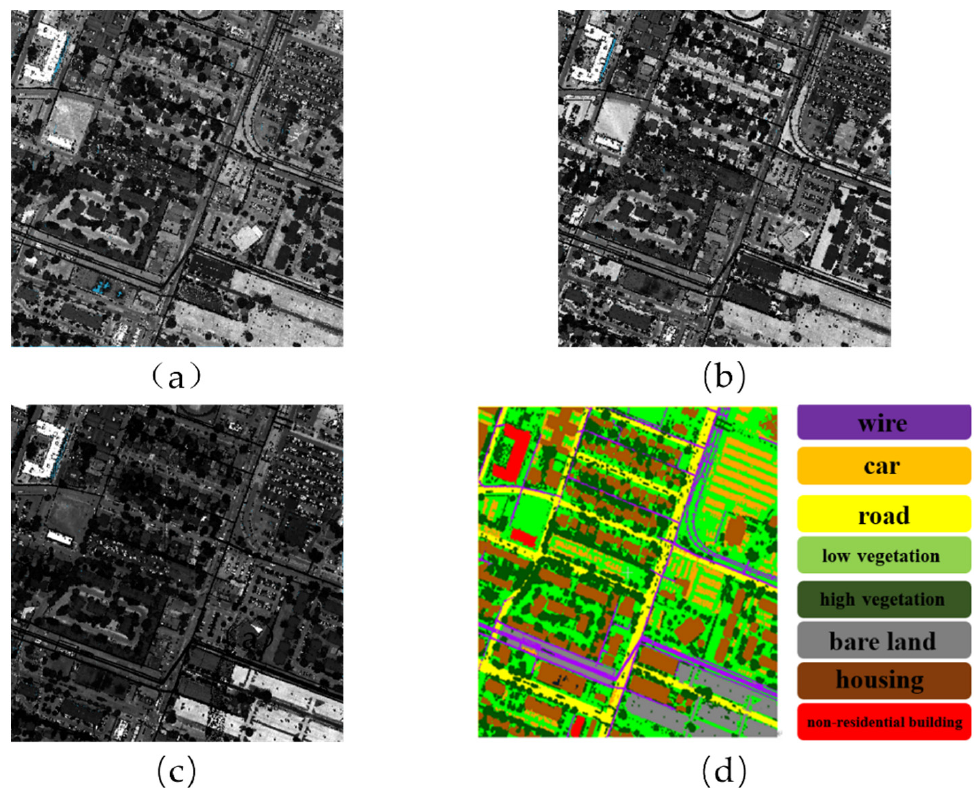
Figure 2. ( a ) The 532 nm channel point cloud intensity; ( b ) the 1064 nm channel point cloud intensity; ( c ) the 1550 nm channel point cloud intensity; ( d ) multispectral lidar point cloud rendered by ground truth value. Table 1. Reference points for the eight classes.